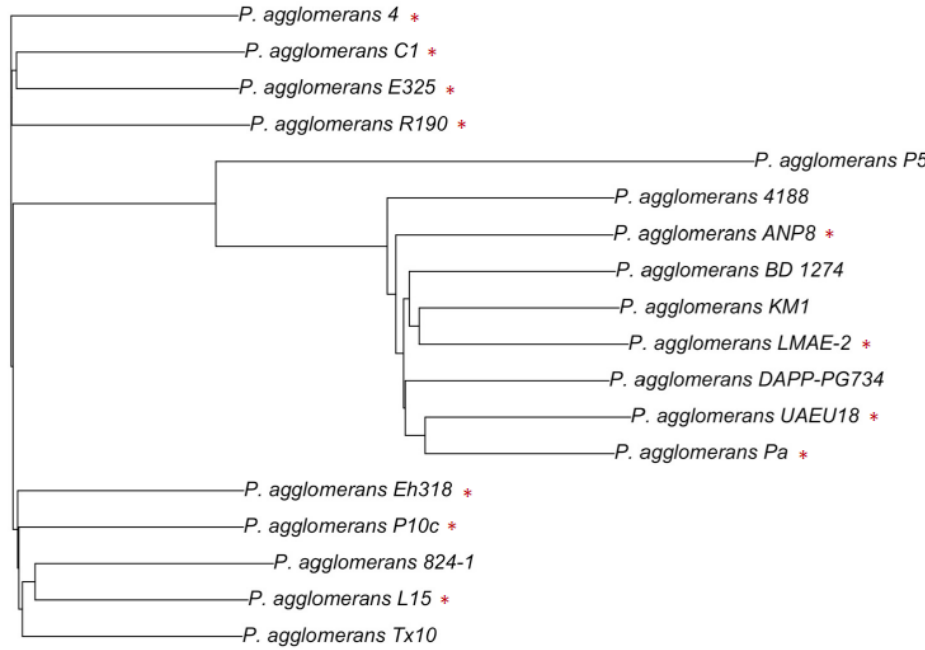
Figure 2. Average nucleotide identity (ANI) distance clustering based on the BIONJ clustering method [132] of Pantoea agglomerans strains with beneficial and harmful traits. Red asterisks indicate beneficial strains.